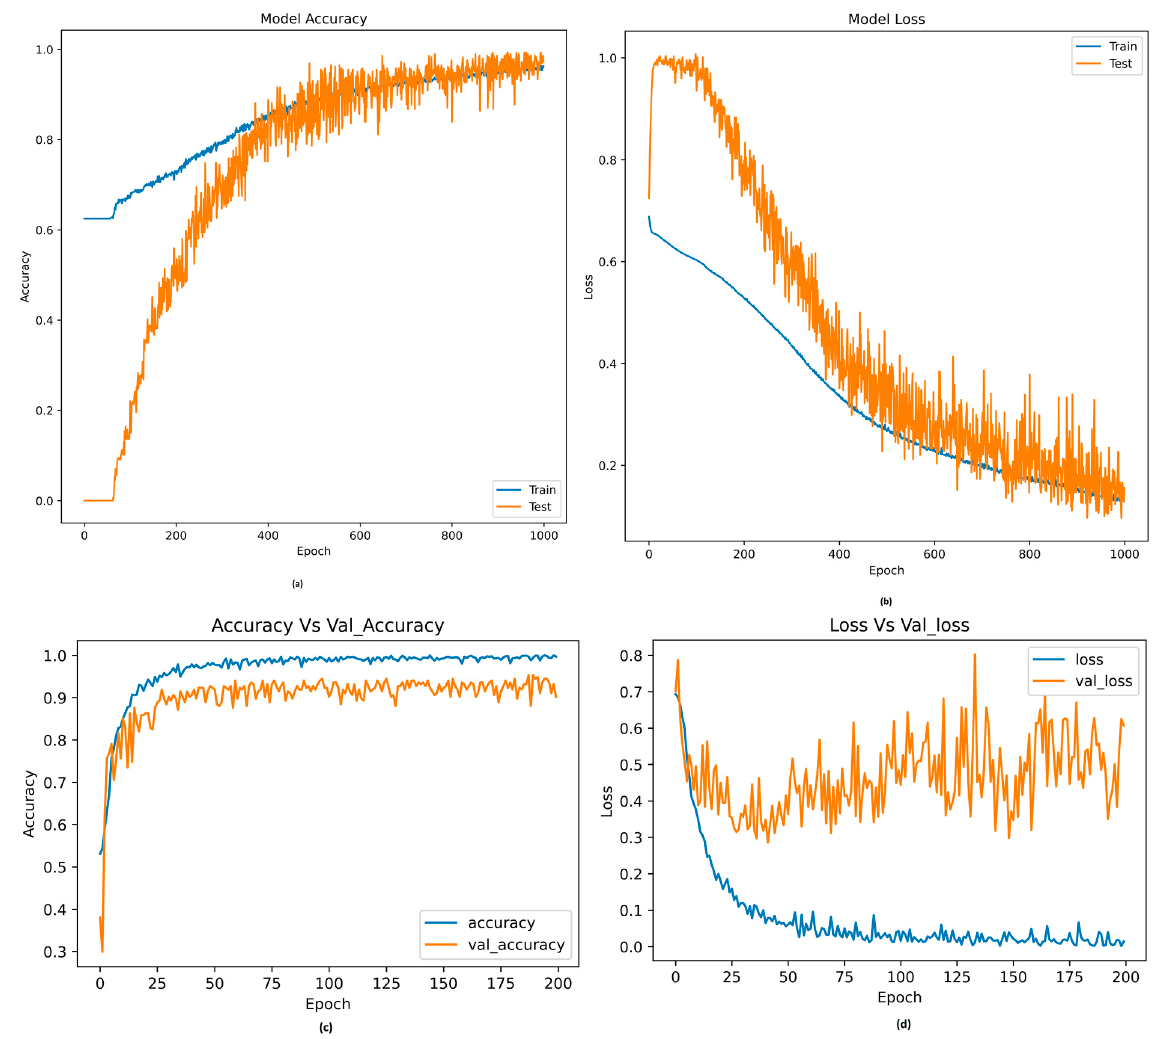
Figure 7. Accuracy and loss curves obtained by the DNN and 1D-CNN models. ( a ) Accuracy curve of DNN. ( b ) Loss curve of DNN. ( c ) Accuracy of 1D-CNN. ( d ) Loss curve of